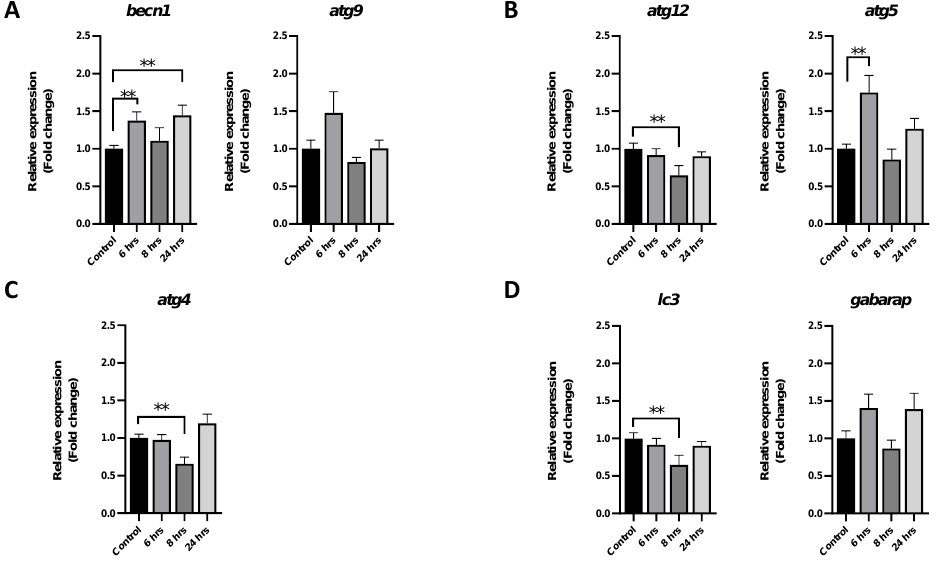
Figure 2. Effect of P. salmonis challenge on the expression of autophagic genes in rainbow-trout muscle cells. Primary cultures of fish skeletal muscle were infected with P. salmonis at MOI 10 for 6, 8, and 24 h. As the control, cells without bacteria were sampled at the beginning of the trial (time 0). (A) Autophagic genes becn1 and atg9 involved in the induction of this process. (B) Autophagosome formation genes atg12 and atg5 . (C) Gene atg4, involved in the elongation of the autophagosome. (D) Vesicle-completion-associated genes gabarap and lc3 . The data are presented as means ± SEMs of triplicates from three independent experiments, using fold change compared to the values of the time 0 group ( n = 3). qPCR analyses were normalized with the ef-1 α and β -actin genes. The difference in transcript levels is denoted by asterisks (**) when the main effects were significant ( p < 0.01). At the protein level, protein autophagic marker LC3-I/LC3-II was evaluated